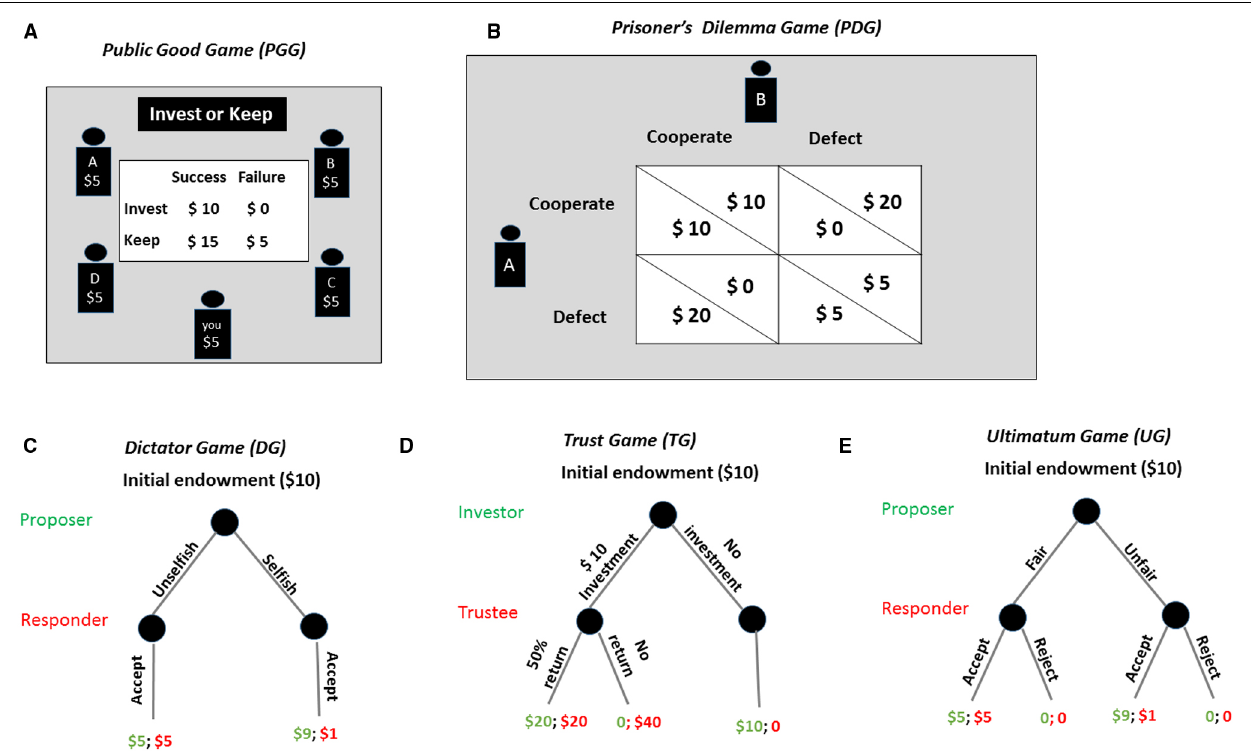
FIGURE 1 | Strategic decision making tasks. (A) The public good game. In this task, subjects are given an amount of money, and they can decide how much to contribute to a common pool. The money contributed would be doubled and split evenly among the group members. (B) The prisoner’s dilemma game. The players each choose to either cooperate or defect with their opponent. Each player’s payoff depends on the interaction of the two choices. For example, the player A can get the largest payoff if he chooses to defect and player B chooses to cooperate, while the worst outcome occurs when he decides to cooperate but his partner defects. (C) The dictator game. The proposer determines a split of a certain